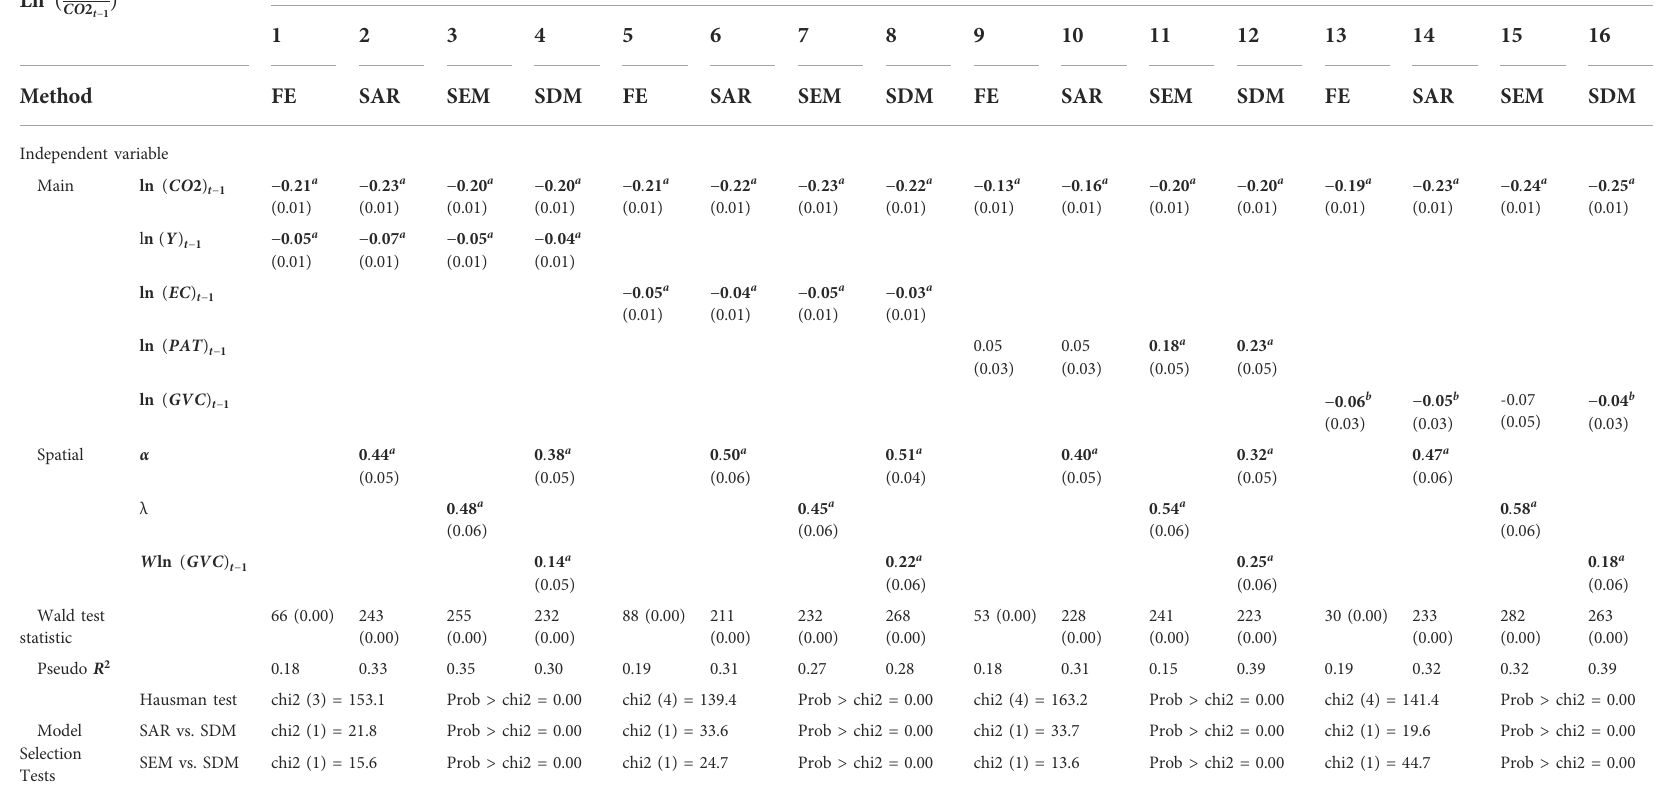
TABLE 5 Estimated spatial panel data